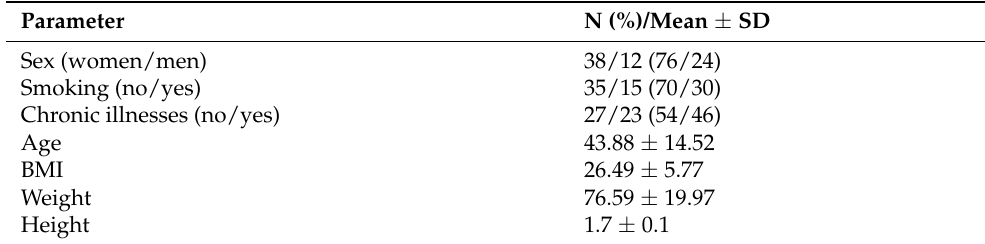
Table 1. Characteristics of the study group.